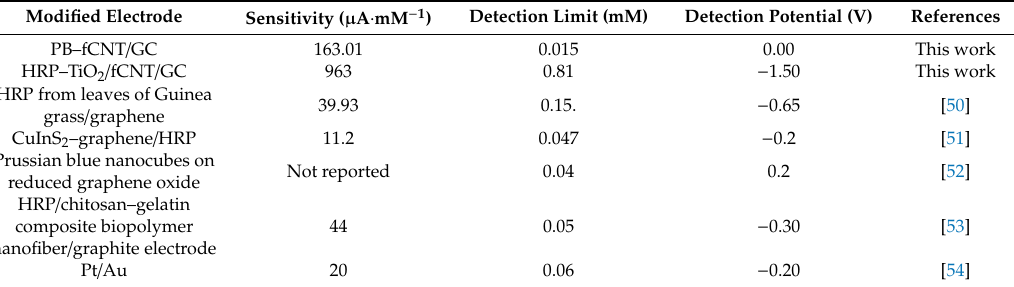
Table 1. Comparison of performance of the modified electrodes with other electrodes reported in the literature.